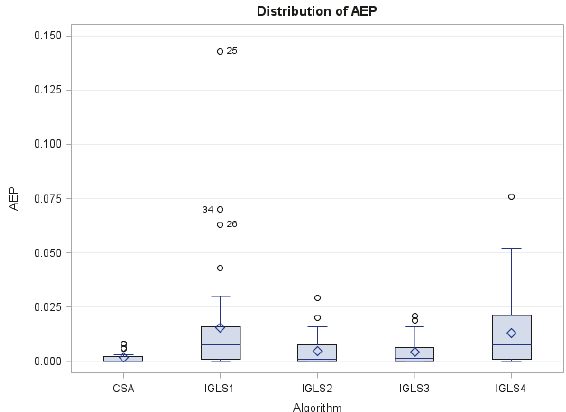
Figure 1: Boxplots of AEP for algorithms.